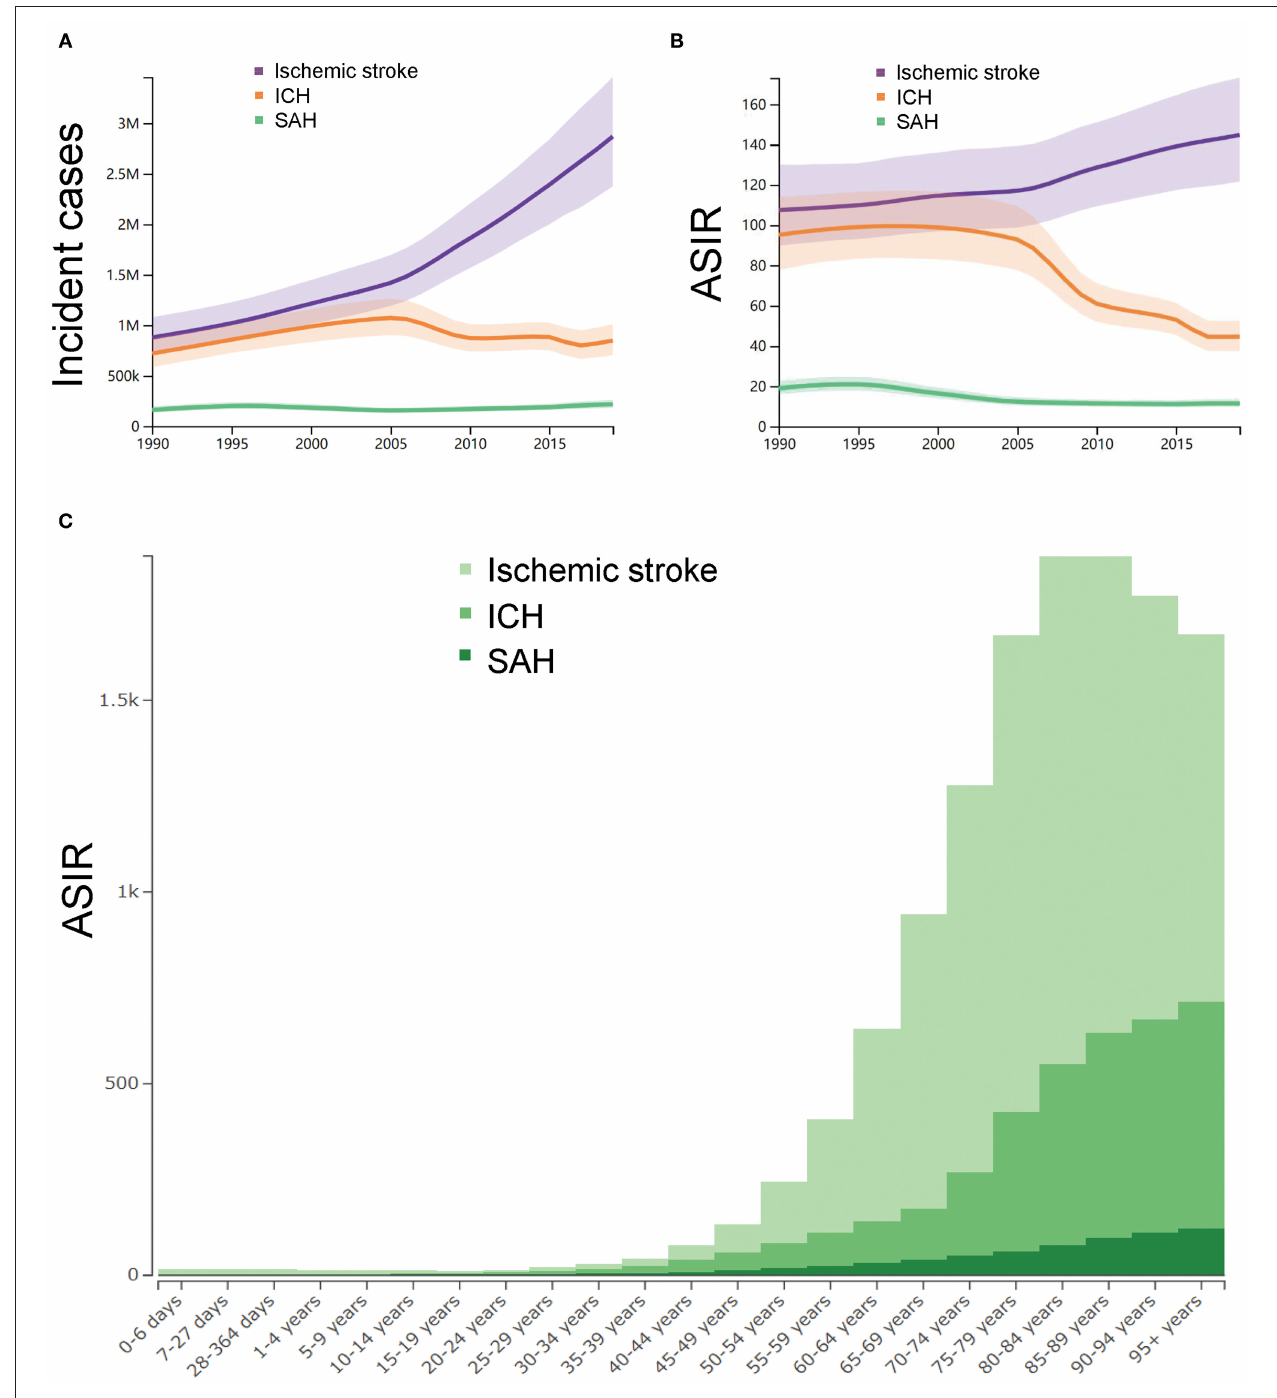
FIGURE 1 | The trends in incidence of strokes. (A) Number of the incident cases with uncertainty from 1990 to 2019 in China. (B) Age-standardized incidence rate per 100,000 with uncertainty from 1990 to 2019 in China. (C) The age-standardized incidence rates per 100,000 of different age groups. ASIR, age-standardized incidence rate; ICH, intracerebral hemorrhage; and SAH, subarachnoid hemorrhage. The figures were generated through GBD Results Tool and GBD Compare Tool.